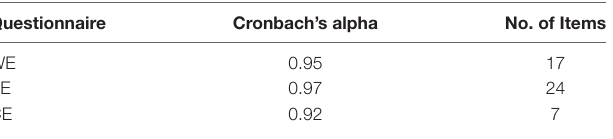
TABLE 2 | Reliability of the questionnaires.